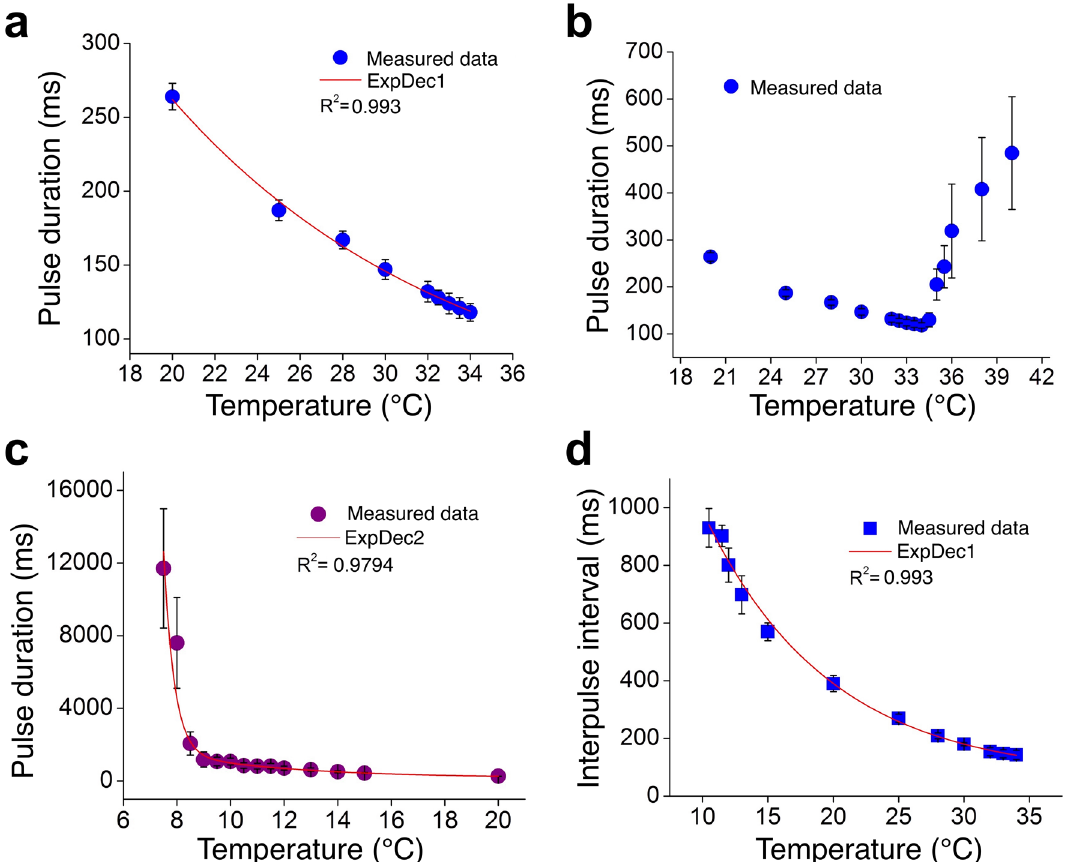
Figure 6. Measurements of time-resolved emissions. ( a ) Variation of the measured flash duration (mean ± S.D.) in the temperature range 20–34 ºC. In this range of temperature, the flash duration decreases exponentially as the temperature increases. This implies that the speed of the luciferase-luciferin reaction increases exponentially up to the temperature optimum shown in ( b ). ( b ) Measured flash duration (mean ± S.D.) at various temperatures in the range of 20–40 ºC. The flash duration is minimum at 34 ºC, which implies the maximum speed of the reaction. Thereafter, the duration increases sharply, indicating sharp decrease in the reaction-speed, with the increase in the temperature. ( c ) Variation of the measured flash duration (mean ± S.D.) in the range of 20–6.5 ºC. The flash duration increases exponentially with the decrease in the temperature up to 7.5 ºC. ( d ) Variation of the inter-flash interval (mean ± S.D.) with temperature from 10.5 to 34 ºC. The variation is instability of the enzyme. Therefore, instead of precisely pinpointing a temperature, it would be safe to indicate a small range of temperature—between 10.5 and 9 ºC. Average values of inter-flash intervals of the firefly S. substriata at temperatures from 10.5 to 34 ºC are shown in Fig. 6d. At the normal laboratory temperature of 28 ºC, the flash interval is measured as 209 ms (Supplemen- tary Table 6); the interval changes exponentially in the range of 20–34 °C. It is easily noticed that the flashes come closer to each other when the temperature rises (Fig. 4), and go away from each other as the temperature decreases from 28 ºC (Fig. 5). This clearly points to the fact that the inter flash interval decreases when the tem- perature increases, and vice-versa. Above 34 ºC, the interval no longer remains regular—some of the flashes are very closely spaced while some are very widely spaced—thus making a statistical analysis pointless. Similarly, below 10.5 °C, flash intervals vary so much that their measurements have to be discarded at those temperatures. In a communication, it has been shown that the average normal flash interval of the firefly decreases with an increase in temperature 25 . In the present case, we propose that a change in temperature over the range of 9–34 °C affects the rate of regular flow of oxygen to the light producing organelles, and this changes the inter flash interval. Cold denaturation at low temperatures and heat denaturation at high temperatures are the probable reasons for the irregularities in flash intervals from below 10.5 °C and above 34 °C. Few proteins have been reported to undergo cold denaturation above the freezing point of water in the absence of denaturants. The yeast frataxin homologue 1 (Yfh1), the C-terminal domain of ribosomal protein L9, the scaffold protein for iron-sulfur (Fe-S) cluster biosynthesis in Escherichia coli , IscU, and the human immuno- deficiency virus-1 (HIV-1) protease are the ones found to exhibit this 26–29 . We propose for addition of the firefly luciferase in the body of a live firefly to this list. Extraction of luciferase from the light organs of dead fireflies and determination of the relevant thermodynamic parameters at these temperatures would confirm this proposition; but that would be a study in vitro, the real flashing situation no longer existing.